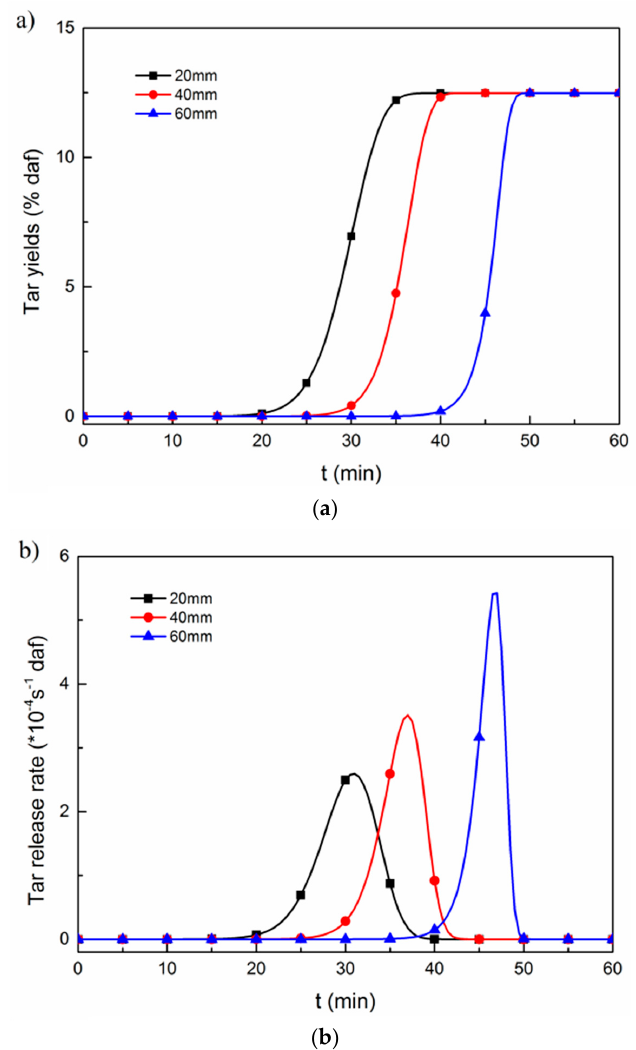
Figure 8. Effect of coal size on the tar yield ( a ) and its release rate ( b ) at center of coal particle, 10